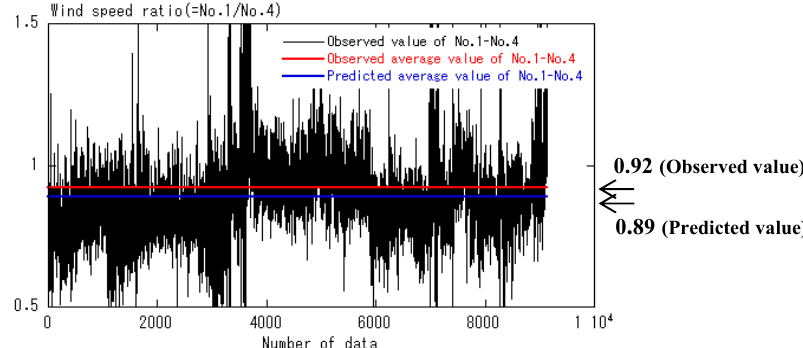
Figure 13. Comparison of hub-height wind speed at WT #1 and WT #10, observation data.